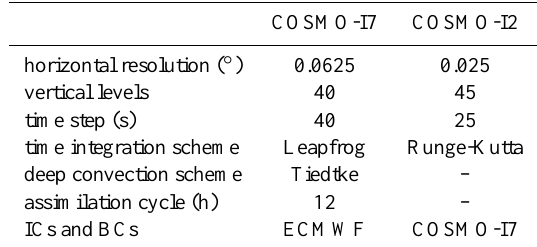
Table 2. Main differences between the 7km and the 2.8km ver-